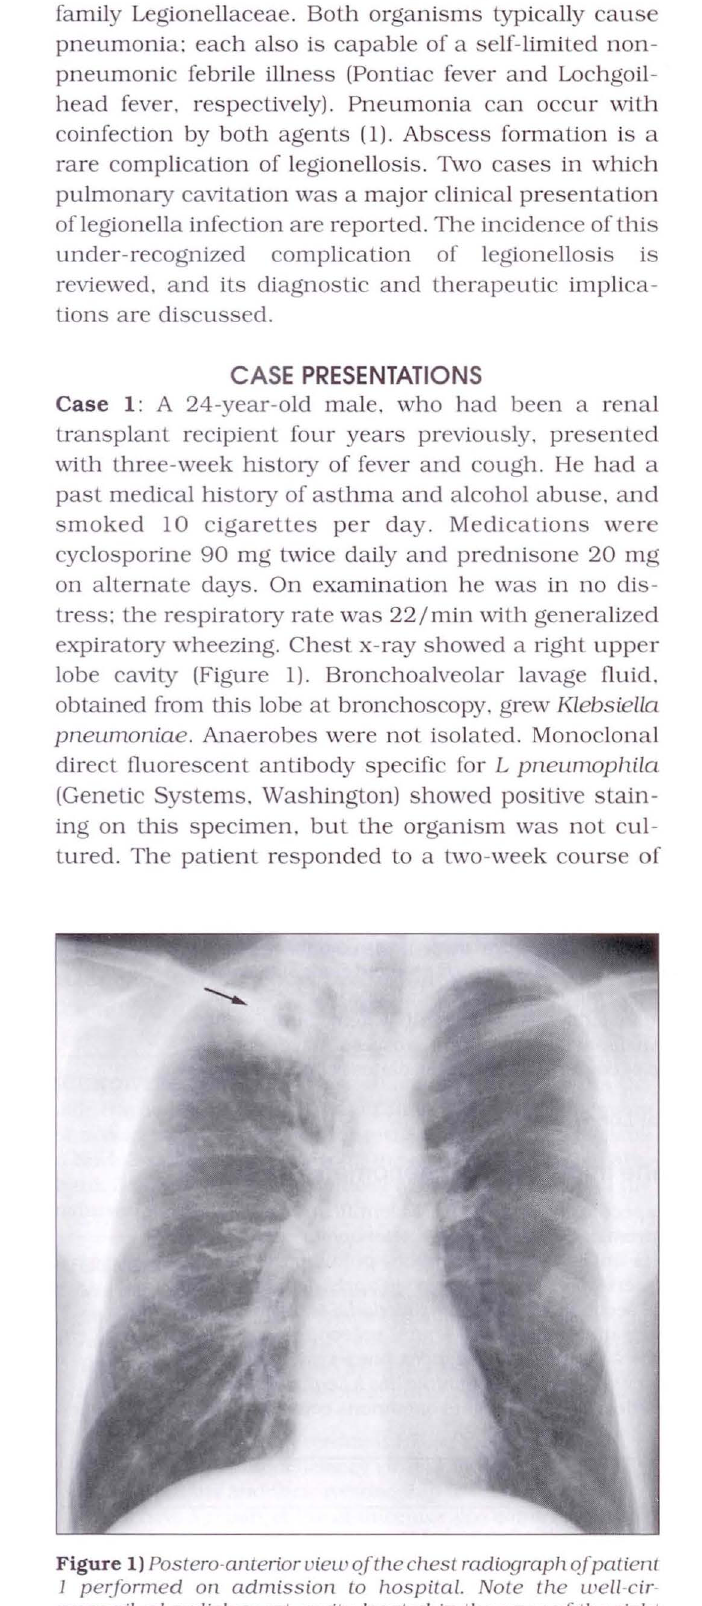
Figure 1) Postero-anterior uiew of the chest radiograph of patient 1 performed on admission to hospital. Note the